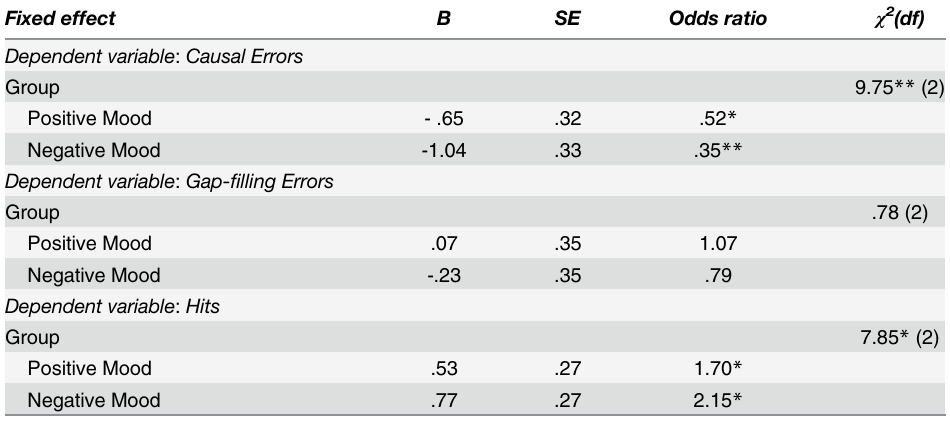
Table 2. Fixed effect of Group on Causal Errors, Gap-filling Errors, and Hits using a logistic mixed- effects model. Fixed